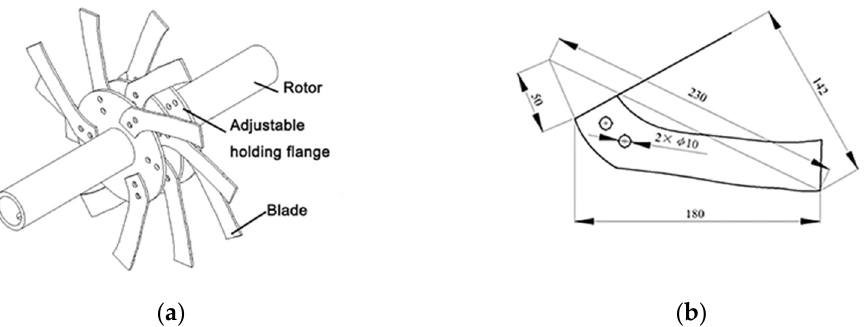
Figure 5. Soil-engaging tool of stubble-crushing tested: ( a ) model of the field validation experimental rotor with twelve blades fitted onto adjustable holding flanges; ( b ) geometric parameters of the plain straight stubble-crushing blade. Table 1. Simulation model key parameters.